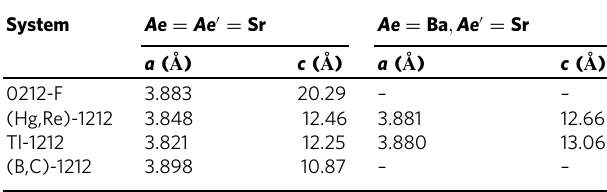
For (Hg,Re)-1212 and Tl-1212, the case where Ae = Ba is also listed.